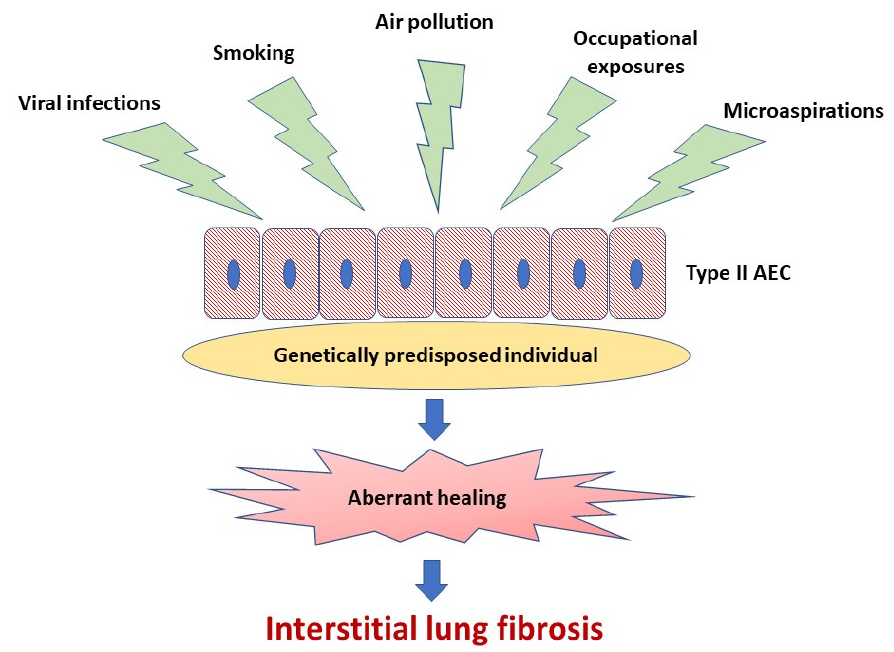
Figure 1. Idiopathic pulmonary fibrosis pathogenesis. Repetitive micro-injuries to the type II alveolar epithelial cells (type II AEC) in the predisposed individuals are leading to aberrant healing at the site of injury and resulting in the exaggerated production and accumulation of interstitial fibrosis. Ambient air pollutants, cigarette smoke, viral infections, occupational exposures and microaspira- tions act as triggers for the disease initiation in a genetically predisposed individual.